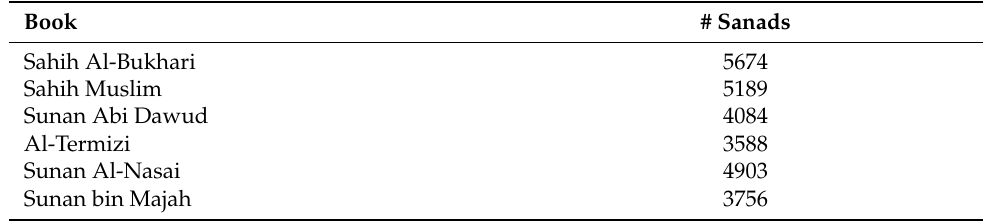
Table 10. Number of sanad s collected from the 6 most famous hadith books.